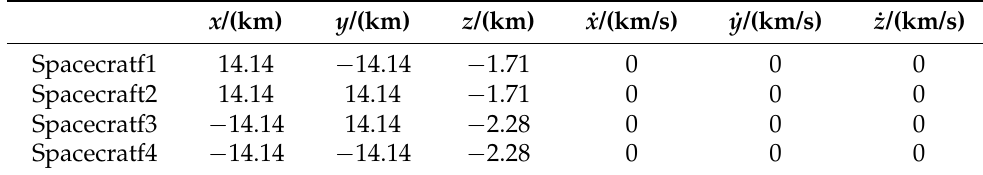
Table 5. Target relative state parameters of spacecraft.